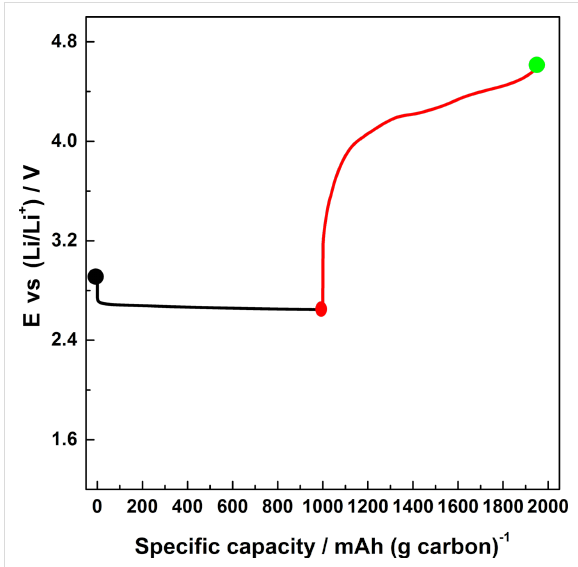
Figure 5: First galvanostatic curve of a Li–O 2 battery discharged up to 1000 mAh·(g carbon) − 1 .